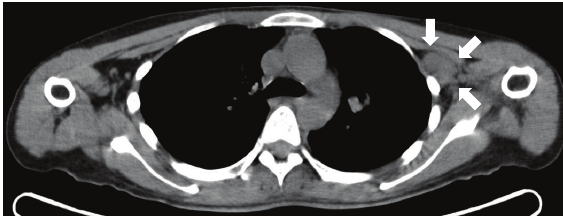
Figure 2: CT image from a 34-year-old female patient diagnosed with cancer in the left breast. The patient had surgery and regular followup care for two years. The followup unenhanced CT of 18 F- fluoride PET/CT showed multiple enlarged lymph nodes including the left axillary lymph node (arrows, 2 . 8 × 1 . 7 cm in size). 18 F-FDG PET/CT six days later confirmed the presence of these metastatic lymph